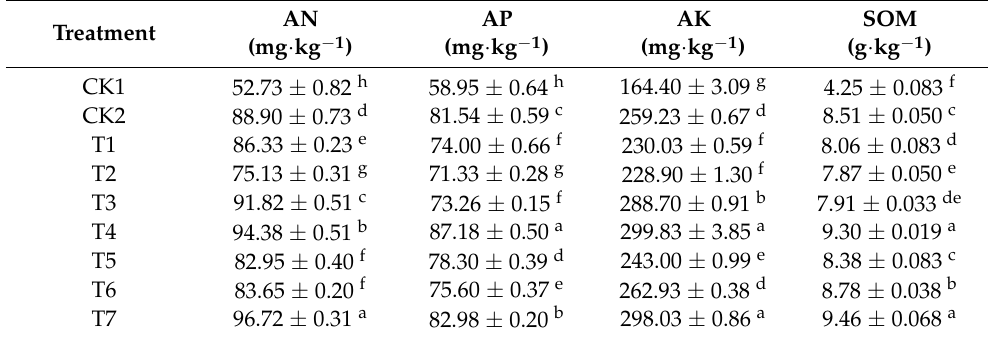
Table 2. Effects of different composting treatments on soil types AN, AP, AK, and SOM. Treatment